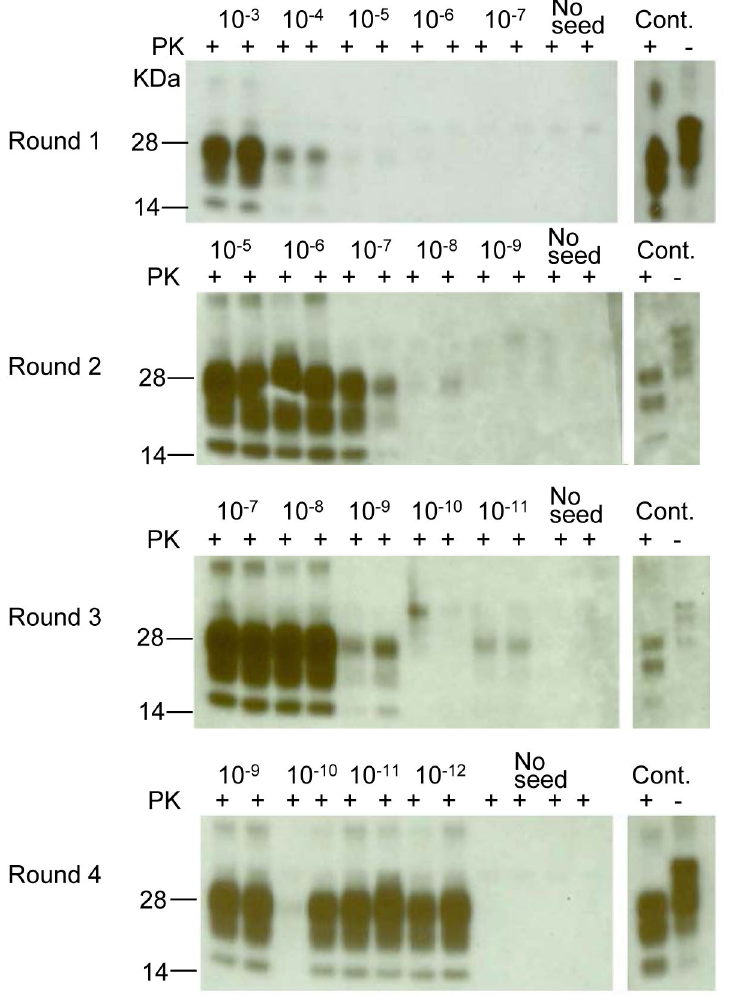
Figure 6. PMCA with a dilution series of vCJD macaque brain homogenate. Macaque vCJD brain was diluted 10 -3 -10 -12 in 10% 170 RBV 170S/S saline-perfused NBH and subjected to 4 rounds of PMCA. Macaque vCJD 5% brain homogenate was loaded as positive control (Cont.) in all 4 rounds. Round 1 shows products of the 10 -3 -10 -7 dilutions, Round 2 shows the 10 -5 -10 -9 dilutions, Round 3 shows the products of 10 -7 -10 -11 dilutions, Round 4 shows the products of 10 -9 -10 -12 dilutions. Prior to electrophoresis, samples were digested with PK. All blots were stained with 6D11 antibody except the control lanes that were stained with 3F4